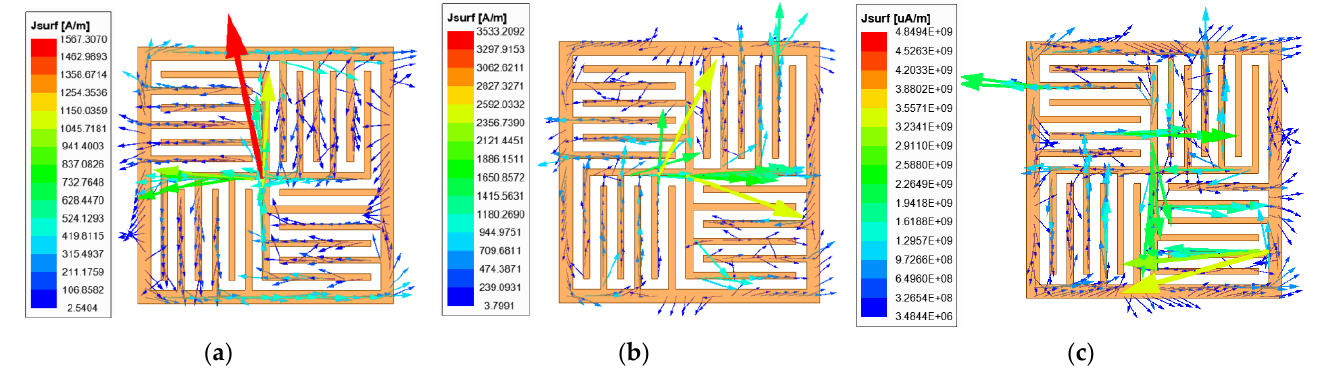
Figure 4. Surface current diagram at: ( a ) f 1 = 7.3 GHz, ( b ) f 2 = 17.1 GHz, ( c ) f 3 = 23.9 GHz.